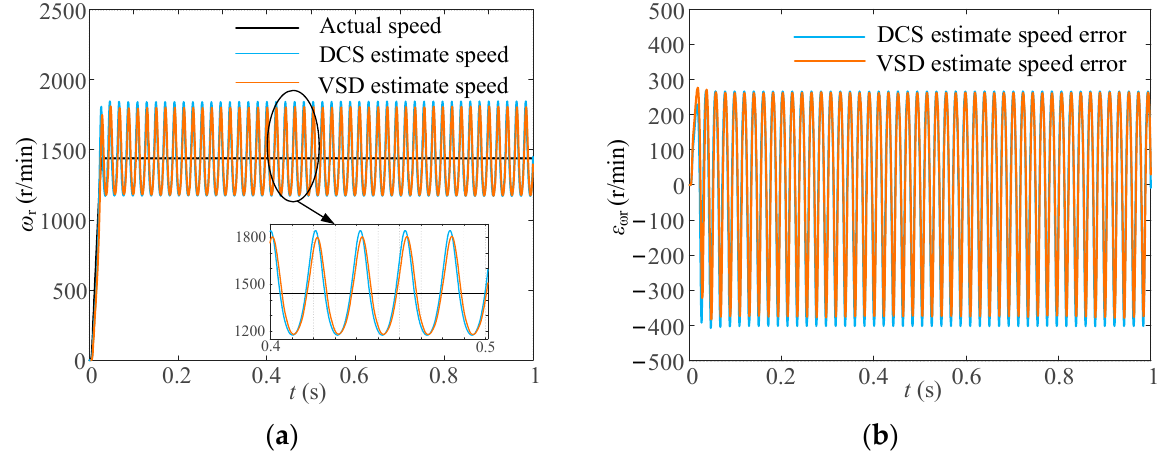
Figure 12. Speed-estimation results without stator resistance identification under steady conditions. ( a ) Speed; ( b ) Speed errors.